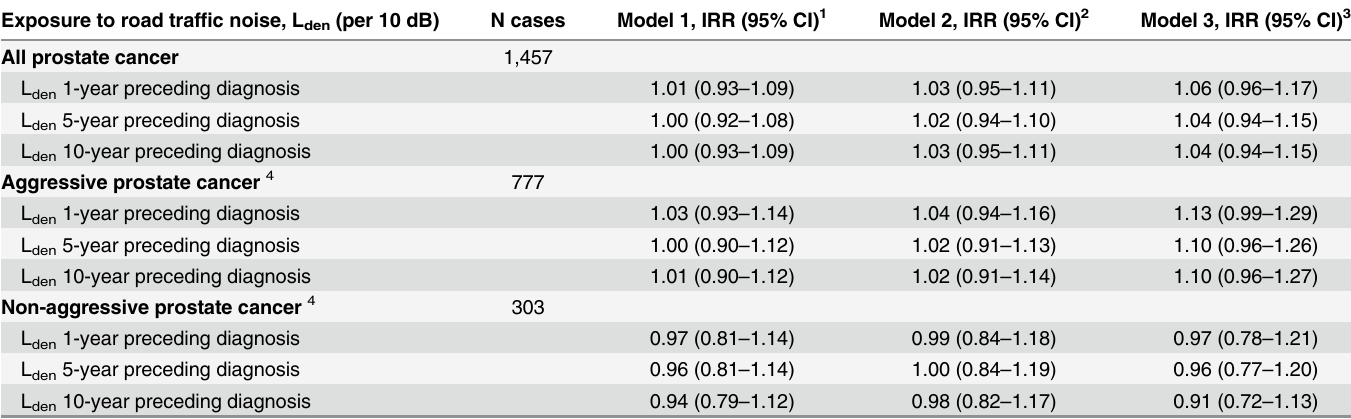
Table 2. Incidence rate ratio (IRRs) of prostate cancer per 10 dB higher level of road traffic noise exposure based on 24,473 cohort participants. Exposure to road traf fi c noise, L den (per 10